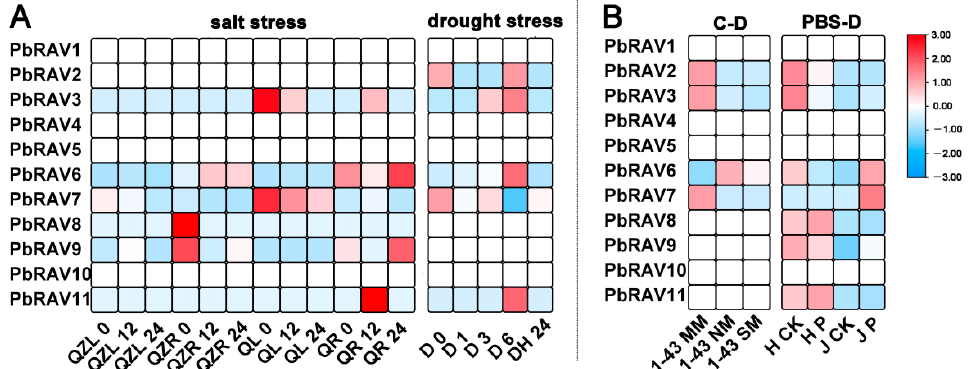
Figure 6. Expression profiles of PbRAV genes under abiotic and biotic stress. ( A ) Abiotic stress included salt and drought stress. ( B ) Biotic stress included cork spot and pear black spot disease. C-D: cork spot; MM: moderate disease mesocarp; NM: normal mesocarp; PBS-D: pear black spot disease; QL: ‘Qaup-1’ leaf, QR: ‘Qaup-1’ root; QZL: ‘Qingzhen D1’ leaf; QZR: ‘Qingzhen D1’ root; SM: severe disease